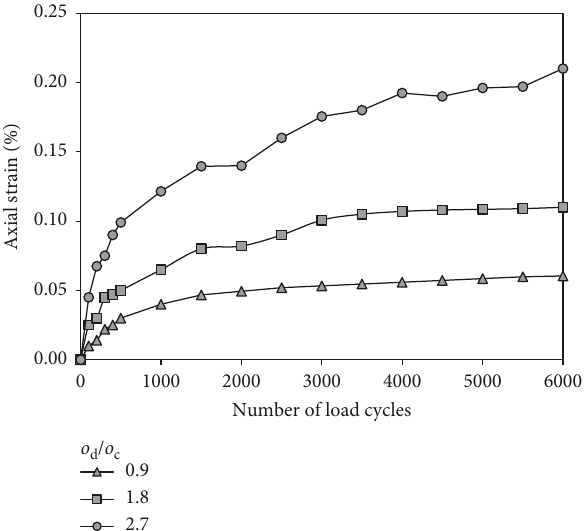
Figure 13: Effect of ratio of “ cyclic deviator stress to the confining ” on the residual strain under long-term repeated stress σ d / σ c ) (